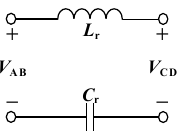
Figure 4. Unified equivalent circuit.